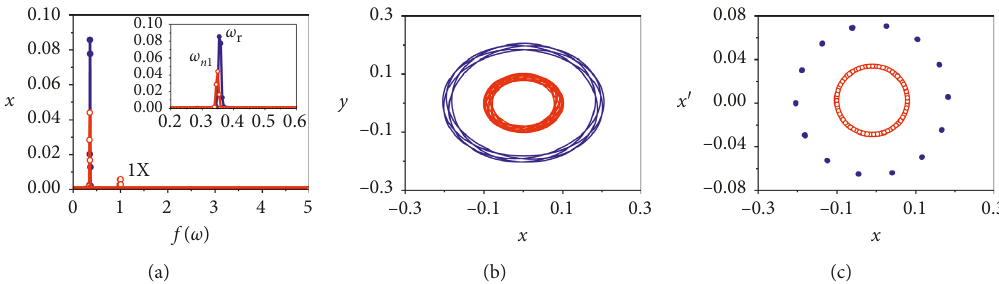
Figure 13: The response of the rotor/seal system with the DVA at s rotor. (c) The Poincar´e map of the x